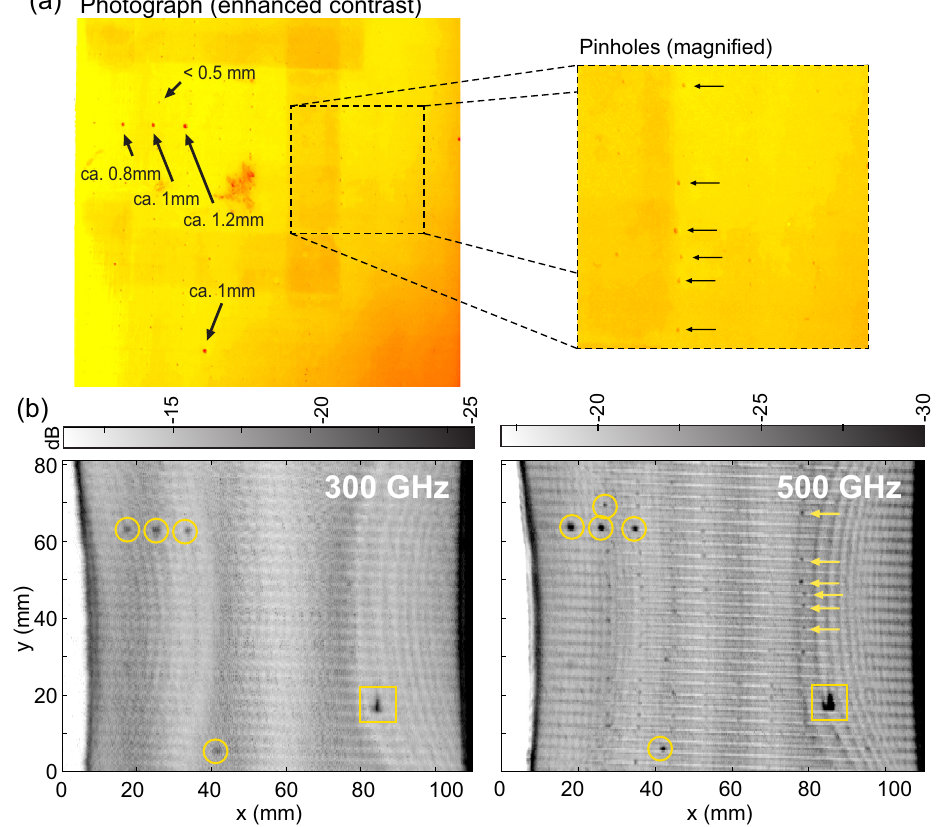
Figure 4. ( a ) Photograph of the backside of a piece of press sleeve with several hole defects of different diameters. The magnified section of the image shows a number of small pinhole defects with <0.5 mm diameter, indicated by the arrows. ( b ) Terahertz images of the investigated sample showing the hidden backside of the sleeve facing the metal cylinder when mounted as in Figure 3. The images were recorded at a data acquisition rate of 20 kHz with the two terahertz transceivers at 300 GHz and 500 GHz center frequency. Defects down to 0.8 mm (circles) as well as an unexpected larger defect inside the sleeve (rectangle) can be detected with both systems. The imaging system working around 500 GHz can even reveal a large number of the pinhole defects, the ones marked with yellow arrows corresponding to the pinholes in ( a